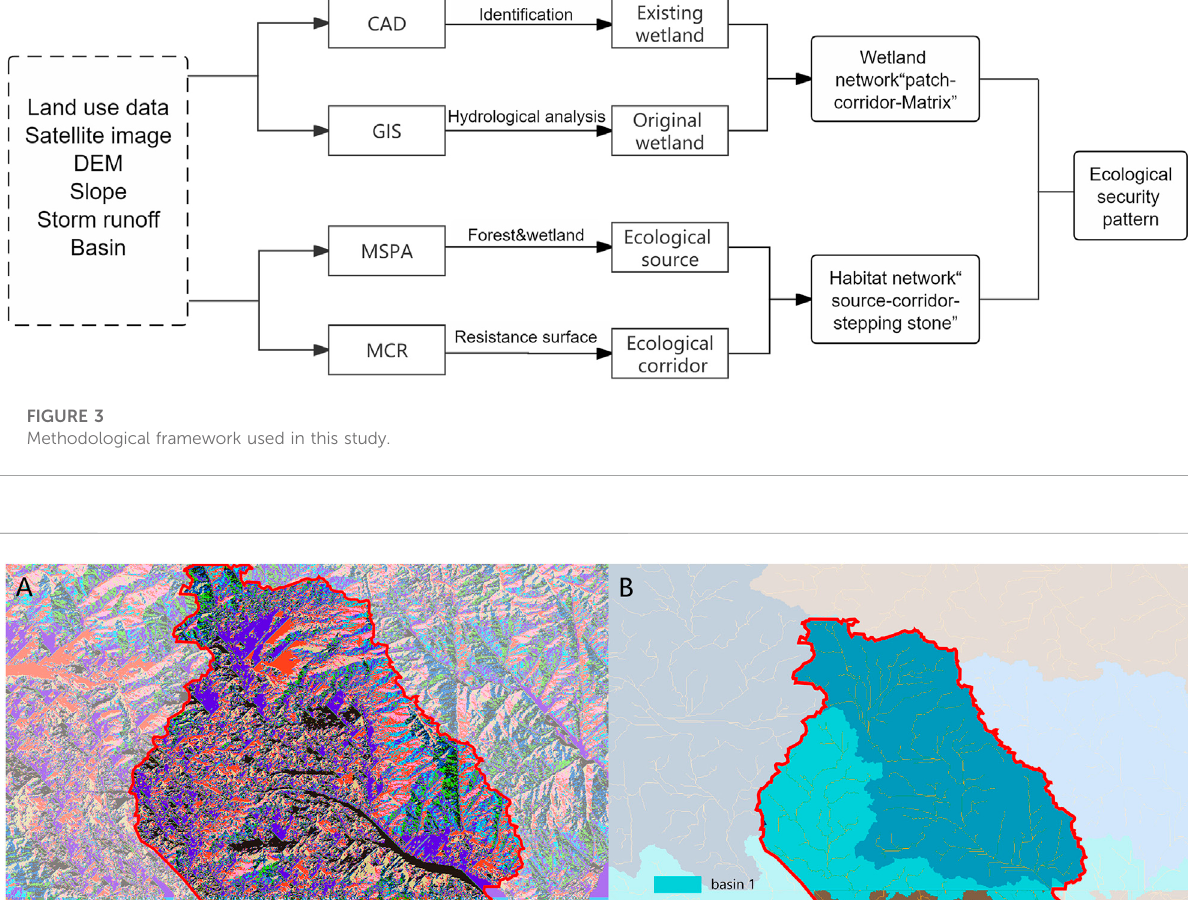
Frontiers in Environmental